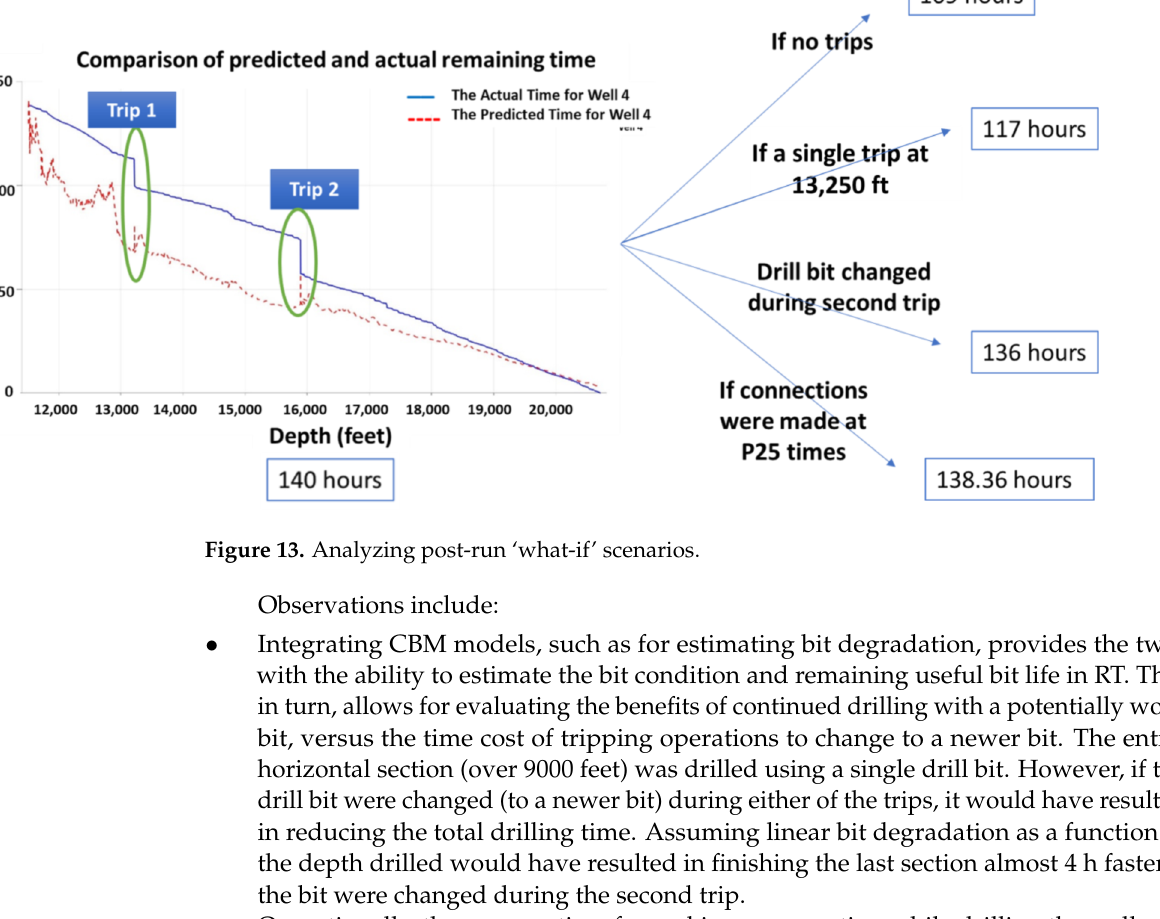
Figure 13. Analyzing post- run ‘what - if’ scenarios.